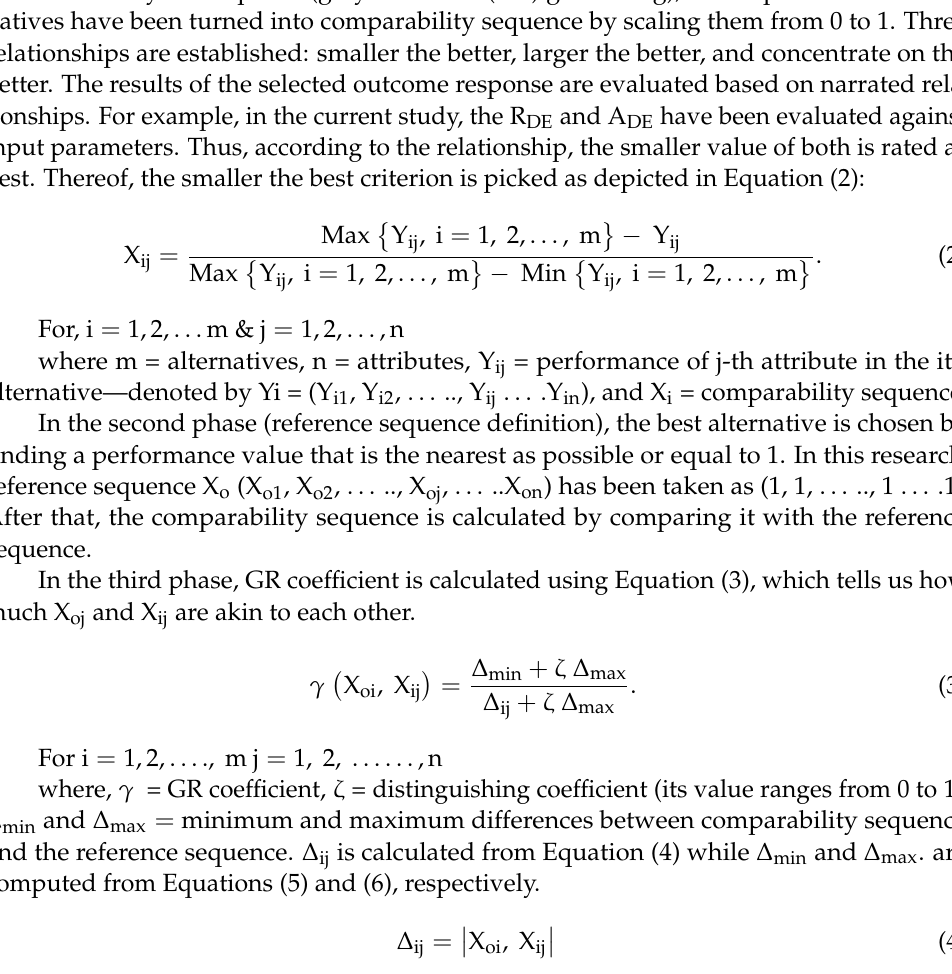
Figure 4. Procedure for GRA.